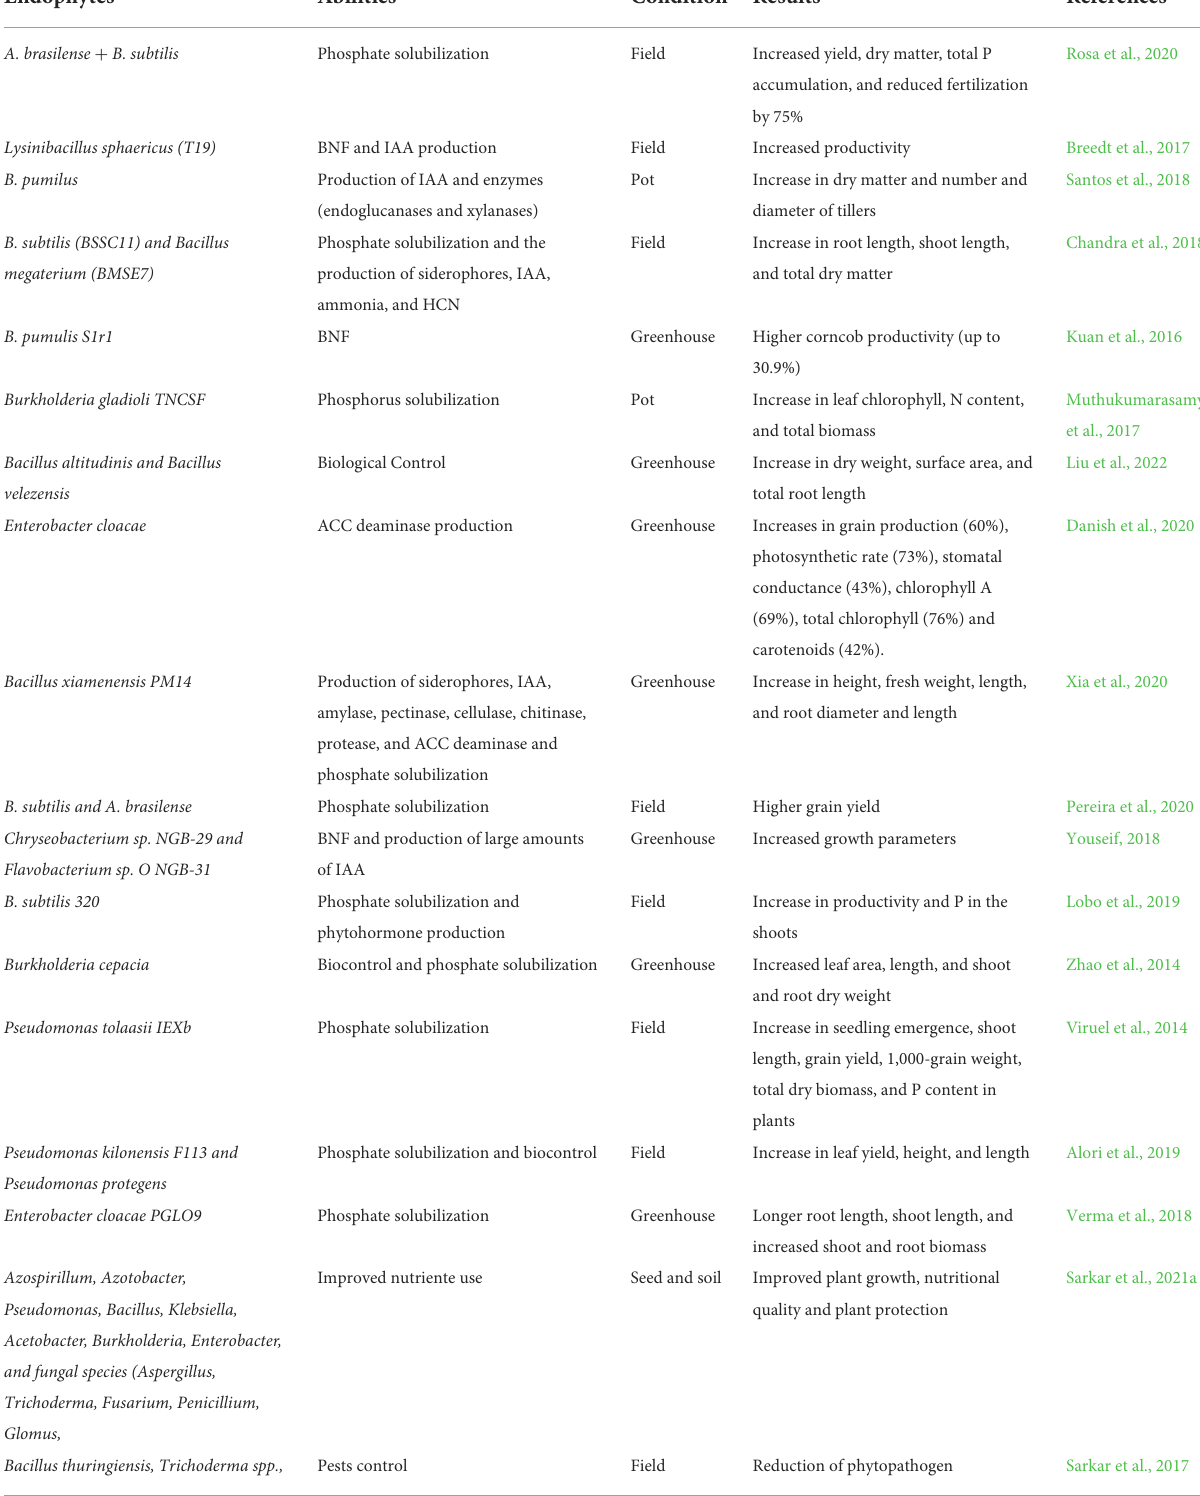
TABLE 1 Bacterial species, abilities, experimental conditions, and results promoted by the application in